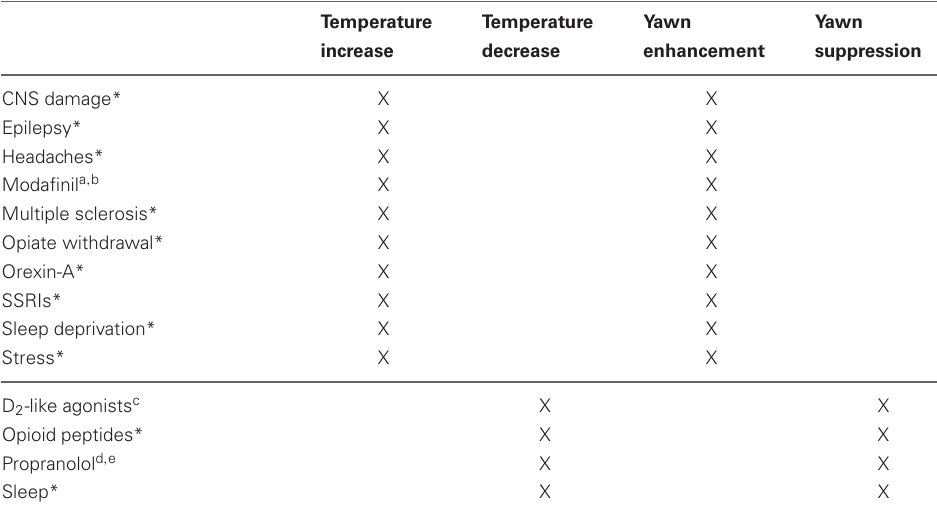
Table 3 | How thermoregulatory changes influence yawning in humans: medical conditions, drug use and behavior (modified from Gallup and Gallup,